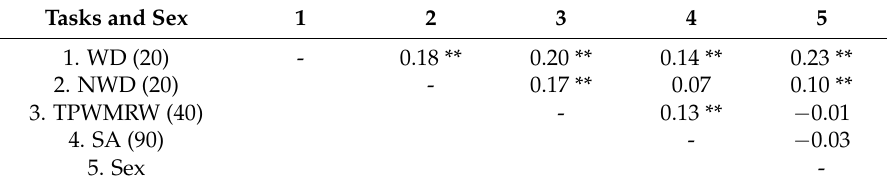
Table 3. Correlations between reading and spelling measures and sex ( N = 686).